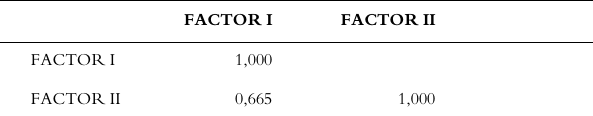
TABLE 6 INTERCORRELATIONSOF FACTORS